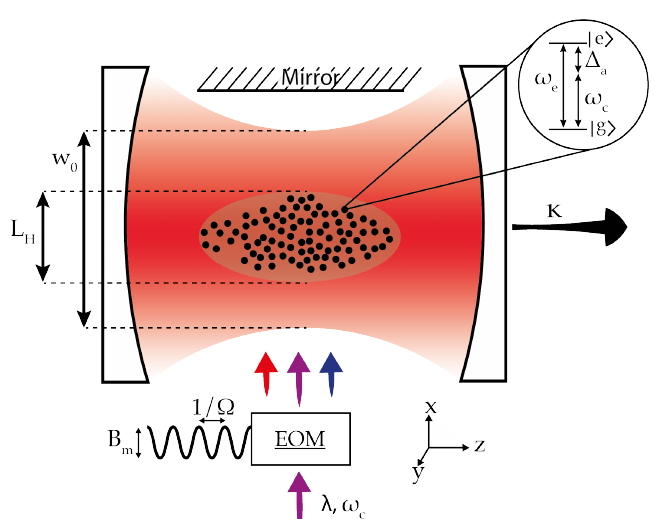
Figure 1: The physical setup considered, consists of a linear cavity with a waist of w . Inside the cavity ultracold bosonic atoms are confined within a cigar-shaped 0 harmonic trap, with a transverse harmonic oscillator length of L . Each atom is H modelled as a two-level system with excitation energy ω . The atoms are transver- e sally pumped with a laser of frequency ω and pump strength λ . The laser is sent c through an electro-optical modulator which introduces a periodic phase-modulation with period 1 / Ω and depth B . Photons are lost from the cavity mirrors with rate κ , m making the system driven and